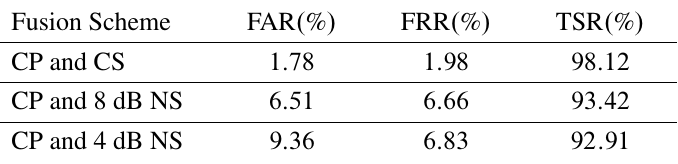
Table 6. Verification rate of match score level fusion of clean palmprint using ICA II MM with speech (clean and